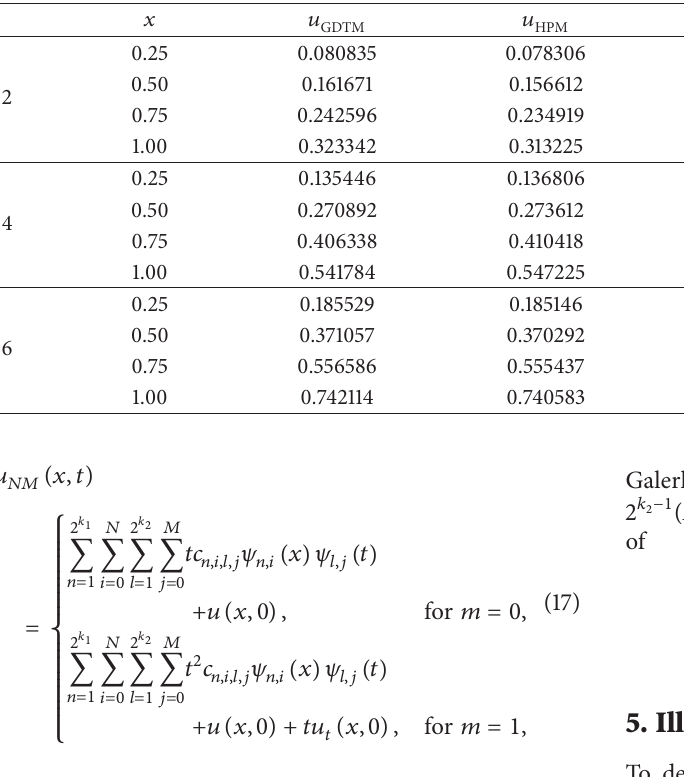
Table 4: Numerical values when 𝛼 = 0.75